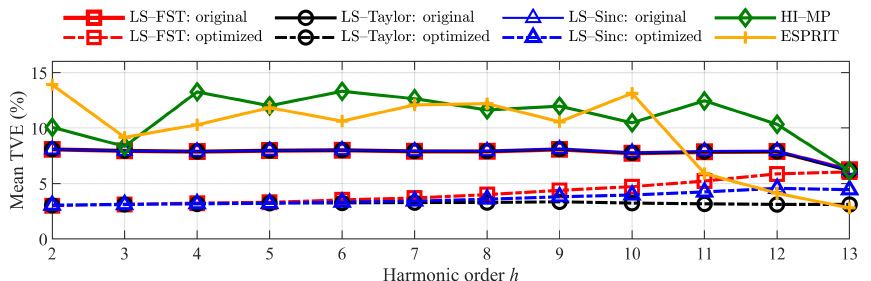
Figure 8. The mean TVE of LS-FST, LS-Taylor, and LS-Sinc with and without the proposed optimiza- tion, as well as the HI-MP and ESPRIT methods under OBI amplitude